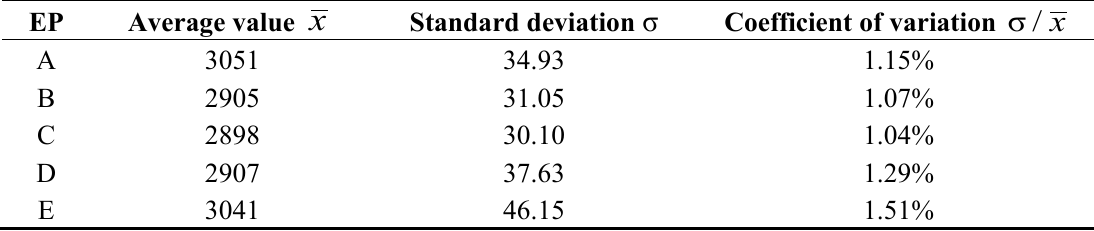
Table 2. The calculated results of the sample